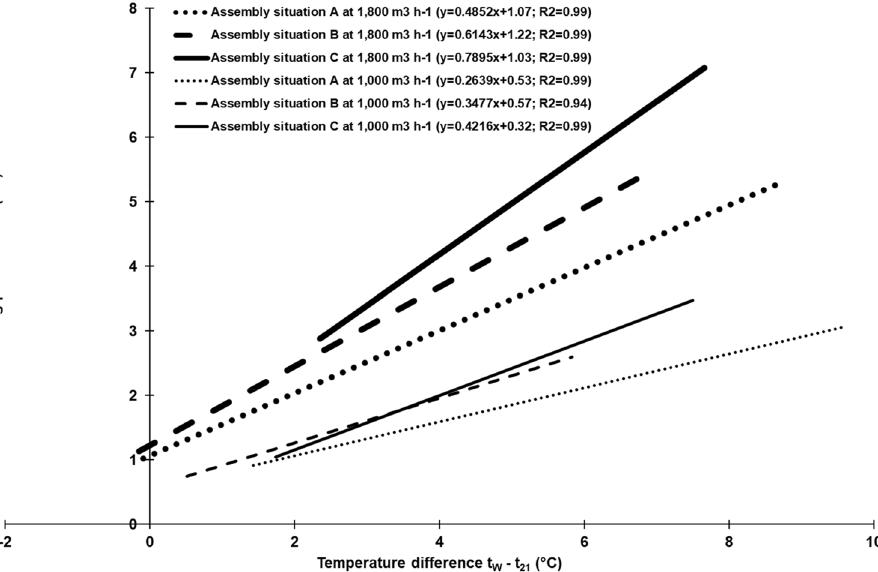
Figure 4. Relationship between heating performance of the exchanger scrubber pilot-plant and the temperature difference between scrubbing water and outside air (Δ t W –t 21 ) at different assembly situation of the heat exchanger and different air flow rates (n = 20,400 per each experimental setup).